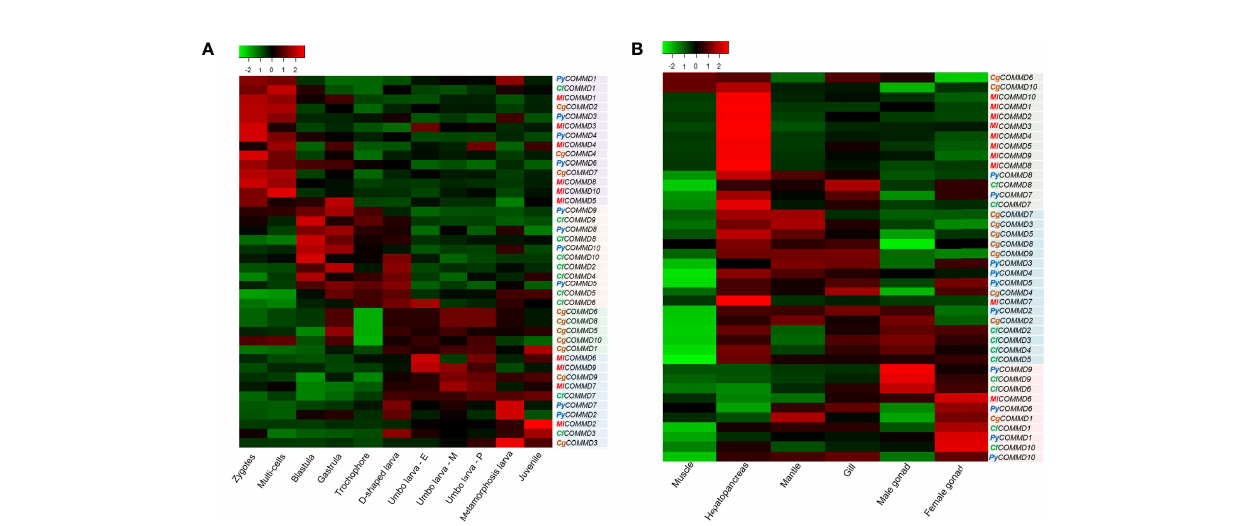
FIGURE 5 | Heatmap of COMMD expression pro fi les (TPM) in embryonic developmental stages and different tissues in four bivalves. The color varies from green to red, representing the scale of the relative expression level. (A) Expression of COMMD s during embryonic development. (B) Expression of COMMD s in adult tissues of four bivalves.